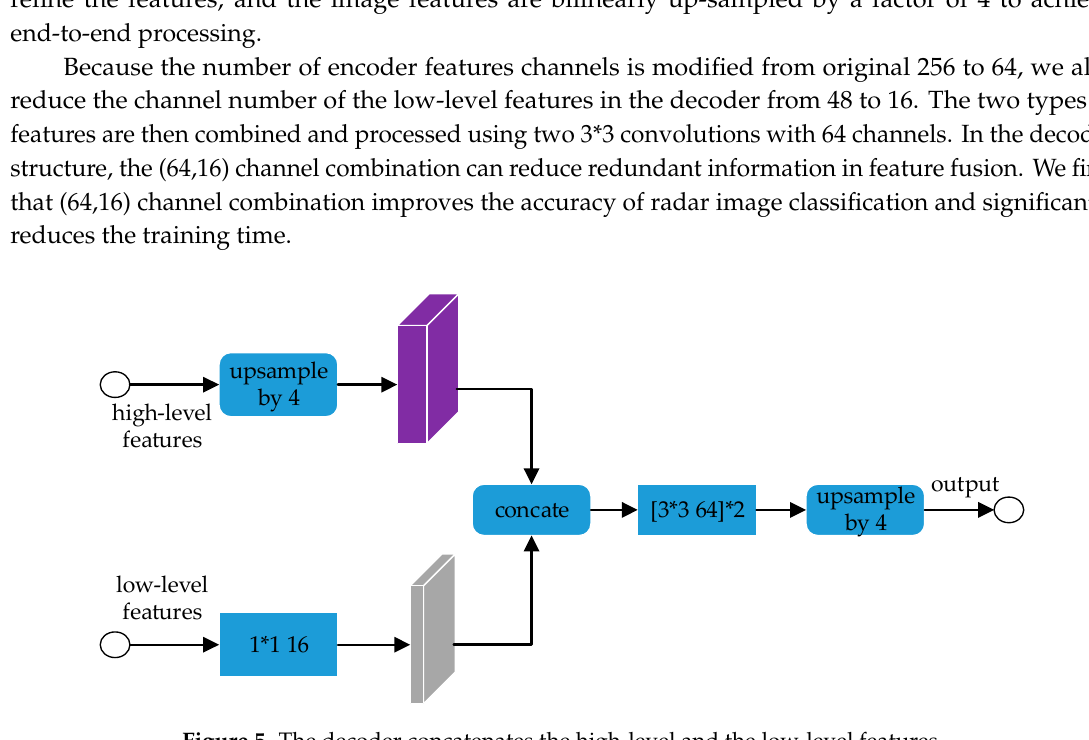
Figure 5. The decoder concatenates the high-level and the low-level features.